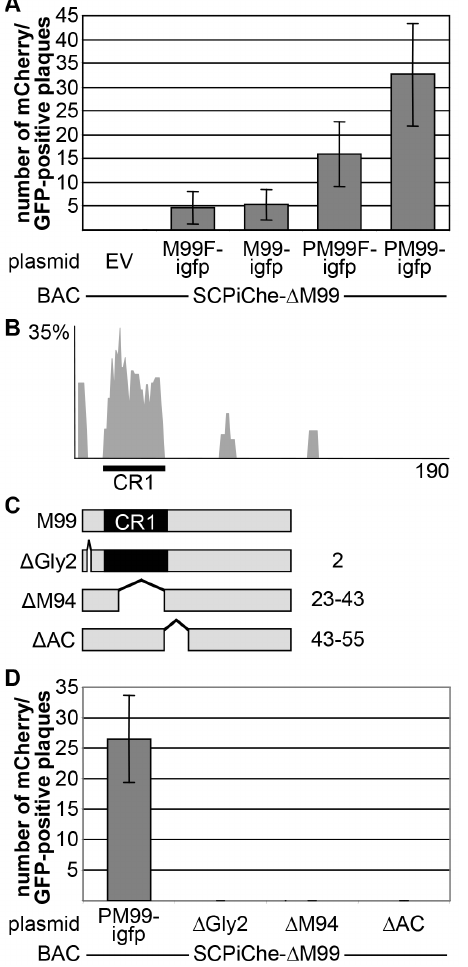
Figure 5. Construction and CCA complementation of pM99 mutants. (A) Flpe-NIH were nucleofected with the indicated BAC and plasmids and plaque formation quantified at 6 dpt. F, Flag-tag; P, P M99 . Depicted are mean and SD of duplicate samples of two independent experiments. (B) The amino acid sequences of 34 pUL11 homologues (accession numbers are listed in Table S2) were aligned using the Vector NTI AlignX program (Invitrogen) via the BLOSUM 62 similarity matrix. The similarity plot was calculated using a 5 amino acid window size, with scores for weak and strong similarity and identity of 0.2, 0.5, and 1.0, respectively. The x axis represents the number of amino acids in the consensus sequence. The conserved region (CR) is indicated below the diagram. (C) Schematic overview of the pM99 mutants. Proteins are depicted as gray bars, the conserved region (CR1) are indicated as black boxes. Deletion mutants are shown with bridged spacing. Numbers on the right indicate the amino acid of pM99 affected by the mutation. (D) Flpe-NIH cells were treated as in (A). Mutants are based on the PM99- igfp plasmid. Depicted are mean and SD of duplicate samples of two independent